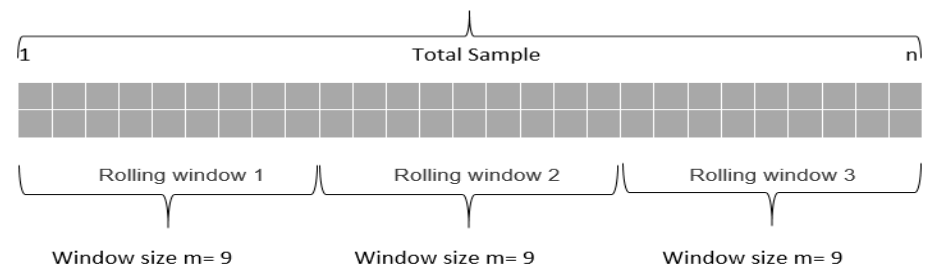
Figure 9. The partition of total predicted samples in each rolling window.